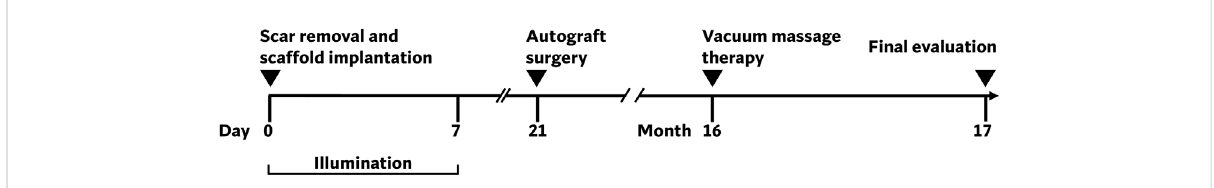
FIGURE 1 Timeline of the procedures. Scar was removed and the photosynthetic scaffold was implanted to cover the newly generated wound (day 0). During the fi rst 7 days after surgery, implanted photosynthetic scaffold was illuminated. On day 21 after implantation, a split-thickness autograft was surgically fi xed on top of the previously implanted photosynthetic scaffold. At month 16, a vacuum massage therapy was applied to the recovered area. Patient was monitored for a total of 17 months after the fi rst